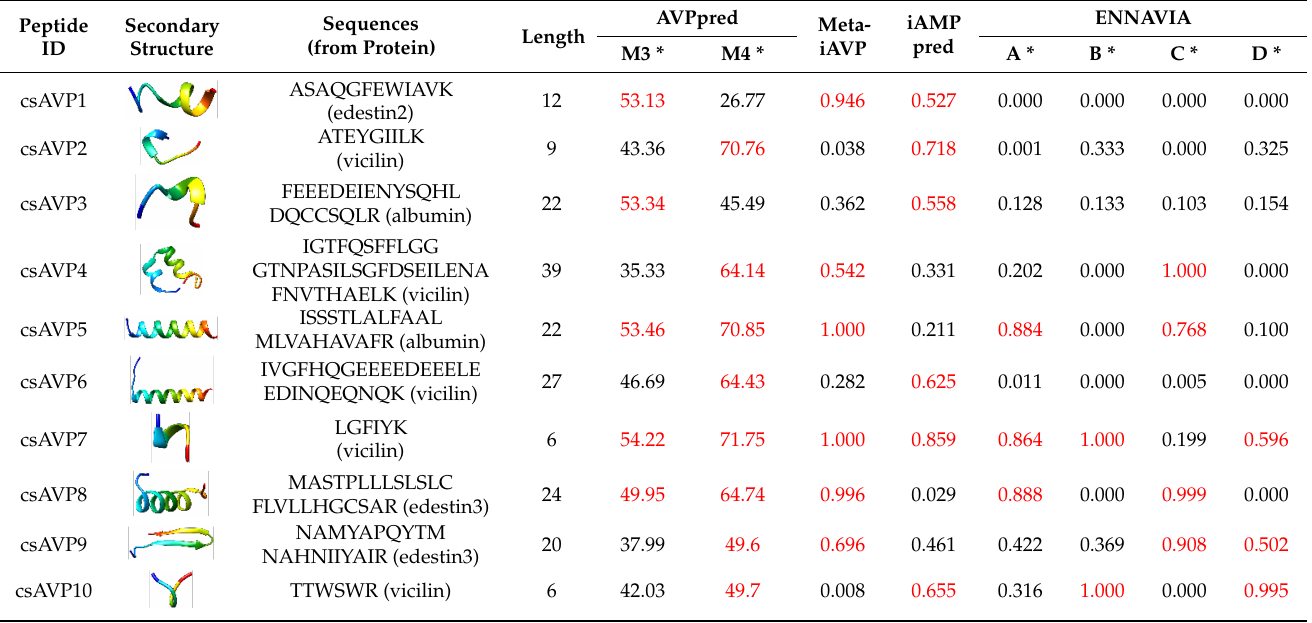
Table 1. Predicted secondary structures, peptide sequences, and antiviral peptide prediction scores from 4 different bioinformatics tools.